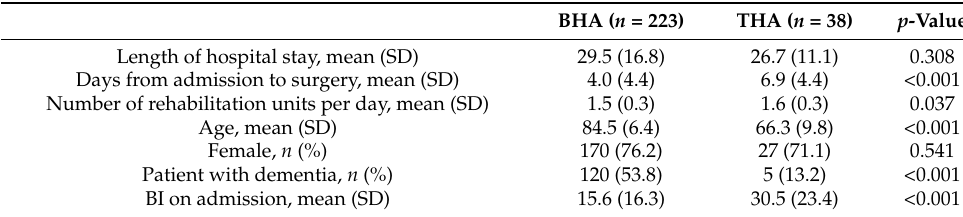
Table 1. Demographic data of BHA/THA patients ( n =